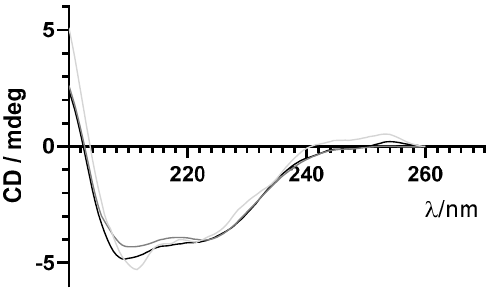
Figure 6. Far − UV circular dichroism (CD) spectra of free insulin (grey line), insulin-loaded NPs (light grey line), and supernatant (darker grey line) in the far − UV range.